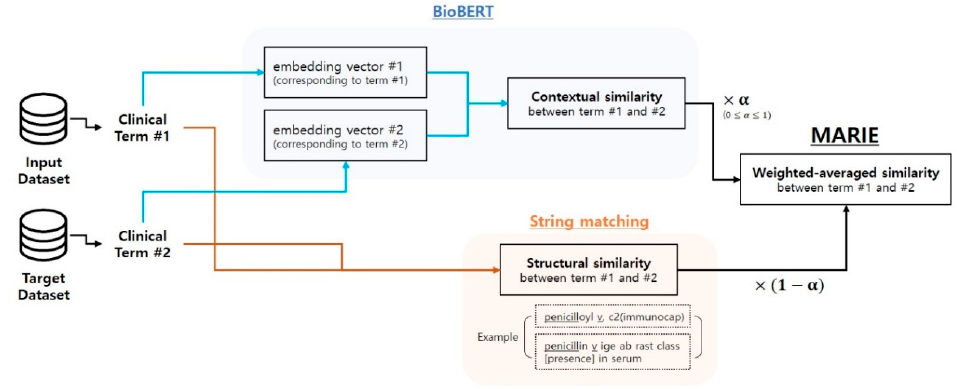
Figure 1. The overall mapping process of MARIE. To find a mapping between the input and the target datasets, MARIE initially compares a clinical term T 1 from the input dataset with a clinical term T 2 from the target dataset. To capture the contextual similarity between T 1 and T 2 , it generates BioBERT embedding vectors for both T 1 and T 2 and calculates their vector similarity, based on a cosine similarity measure. Along with their structural similarity, computed from the string matching method, MARIE calculates the weighted average similarity score between T 1 and T 2 . By ranking these final similarity scores computed from MARIE, T 1 is mapped to T 2 with the highest similarity score.